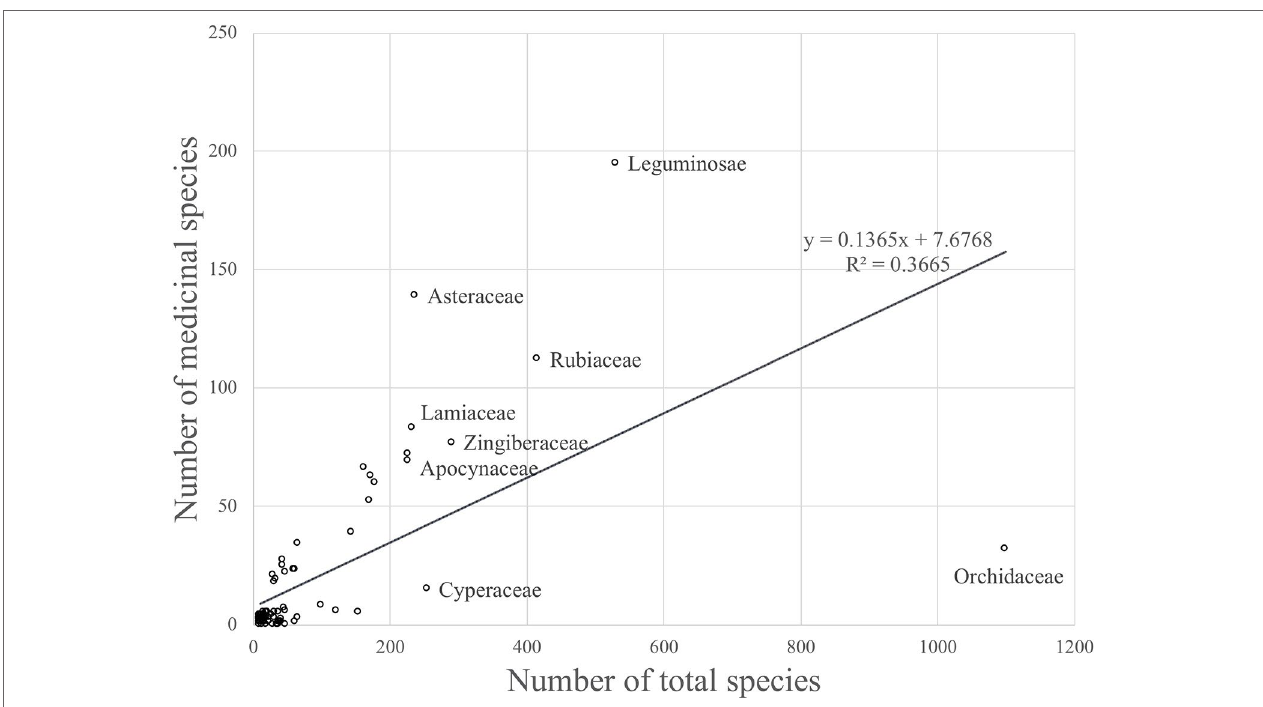
FIgURe 1 | Linear regression model that shows the relationship between the number of medicinal species and the total number of species for plant families occuring in Thailand (R 2 = 0.36646).